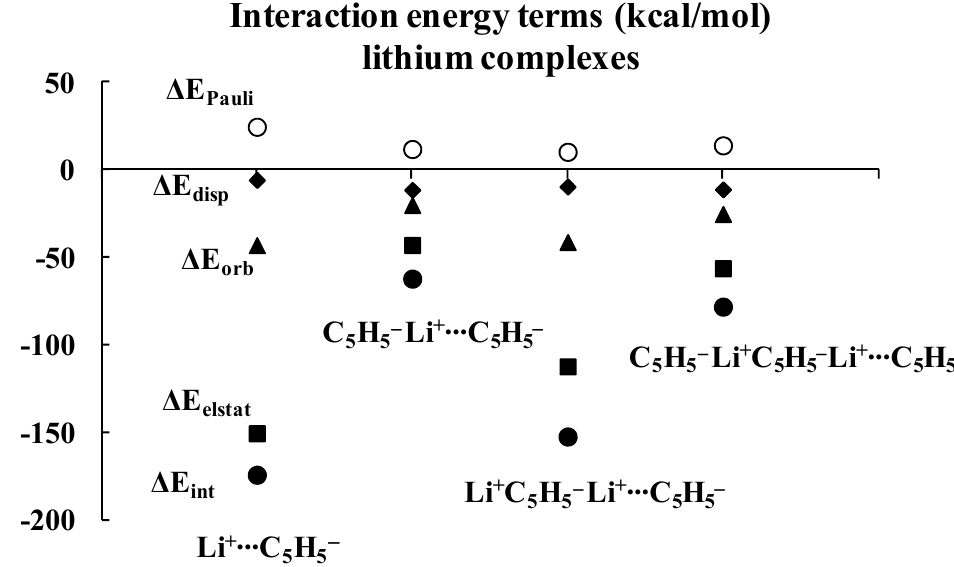
Figure 3. Energies of interactions (and their components according to Equation (1), all in kcal/mol) of a few complexes analyzed here; this figure presents the influence of the extension of the whole lithium system on these energies.